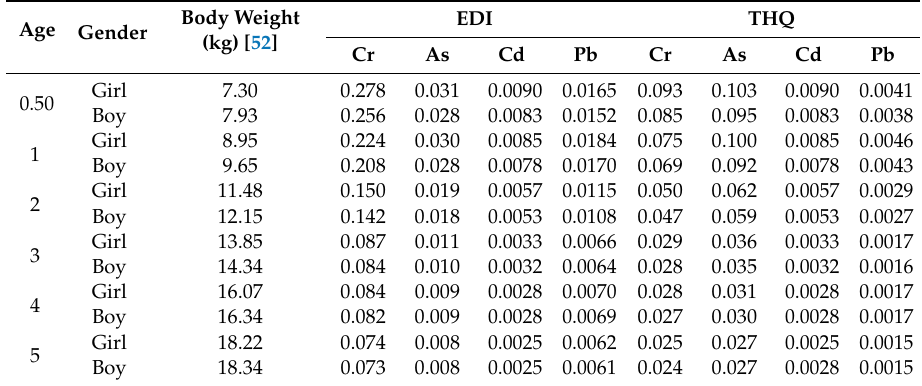
Table 7. Estimated daily intake (EDI) and target hazard quotient (THQ) of Cr, As, Cd, Pb in infants and children due to consumption of infant formula.